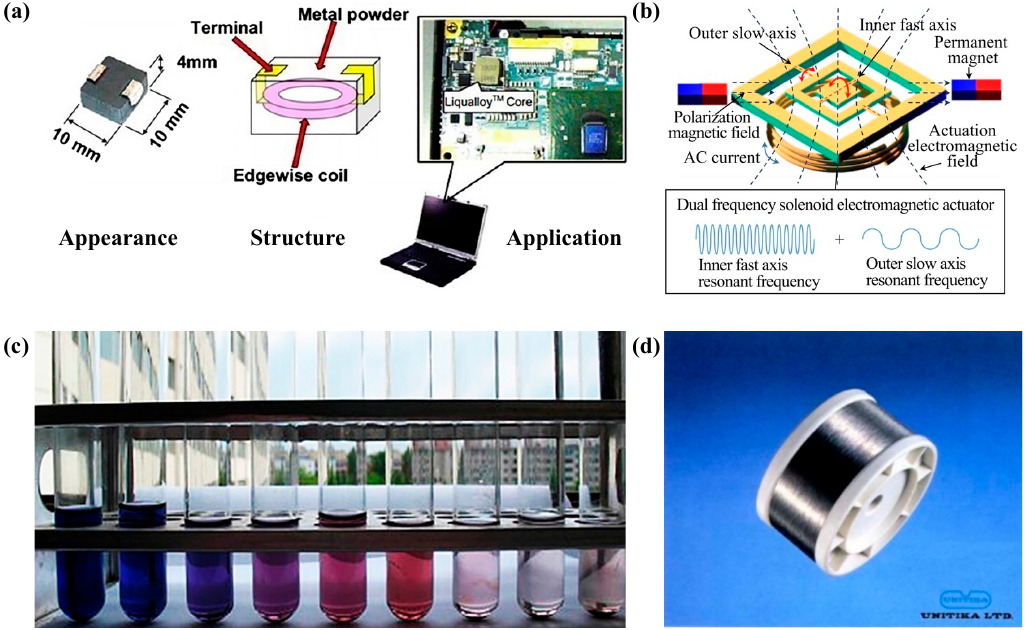
Figure 12. ( a ) Powder cores made of Fe-TM-P-C-B-Si amorphous alloy with high efficiency and low heat generation are used in inductors for laptops, adapted with permission from Ref. [93] 2013, Taylor & Francis. ( b ) A two-dimensional Fe76Si9B10P5 MG microscope was made by Ou, adapted with permission from Ref. [99] 2019, iopscience. ( c ) (Fe0.99Mo0.01)76Si9B13 catalytic purification of wastewater, adapted with permission from Ref. [98] 2010, Elsevier. ( d ) Fe-based amorphous alloy